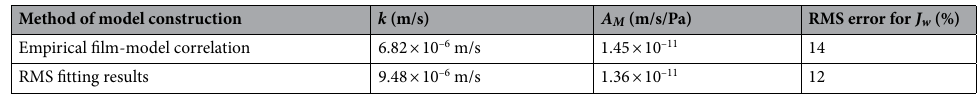
Table 4. Comparison of the two methods for determining the constant of the flux model.